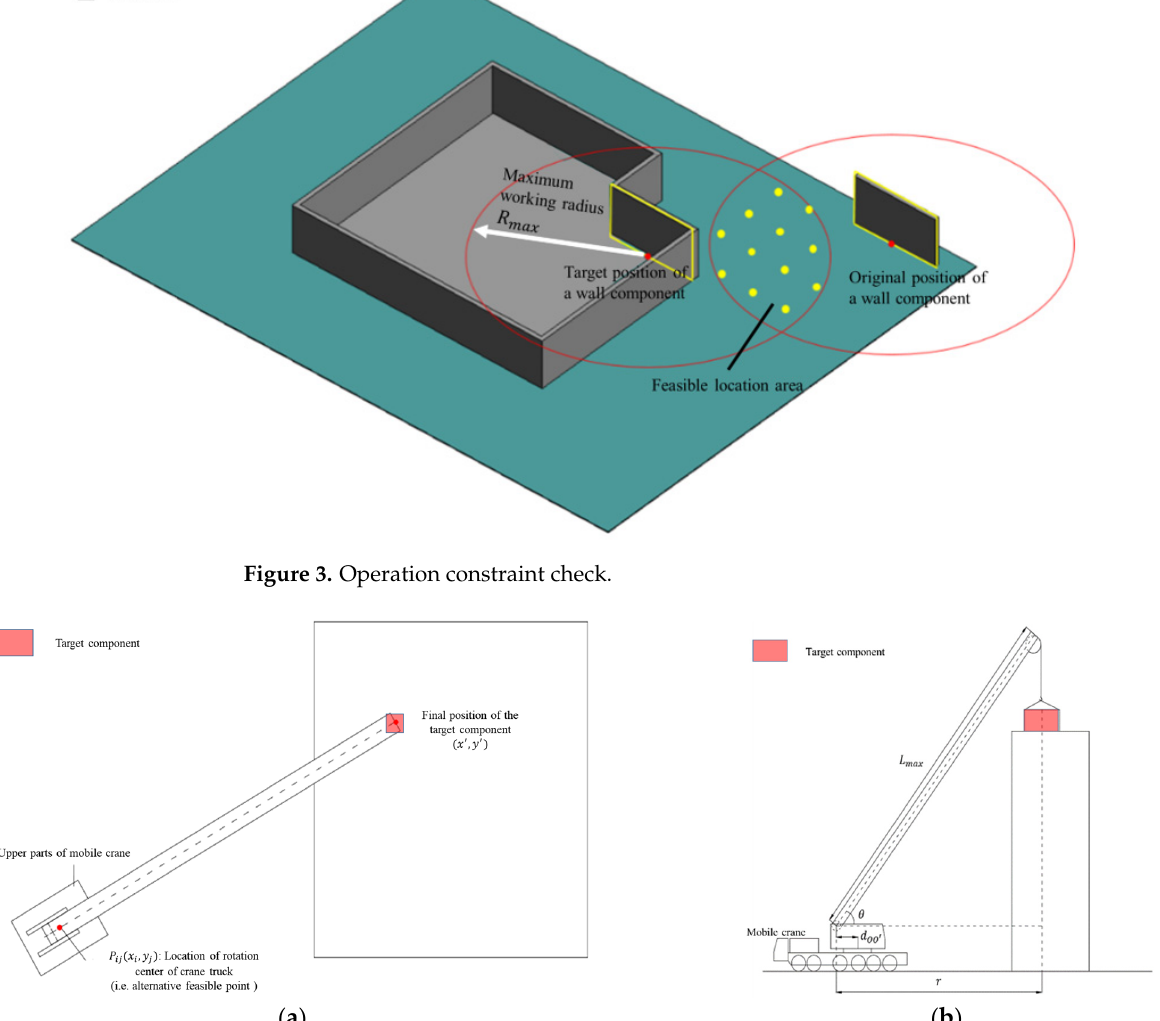
Figure 4. Crane position in the plan and space. ( a ) Lifting boom in the plan, ( b ) Lifting boom in space.